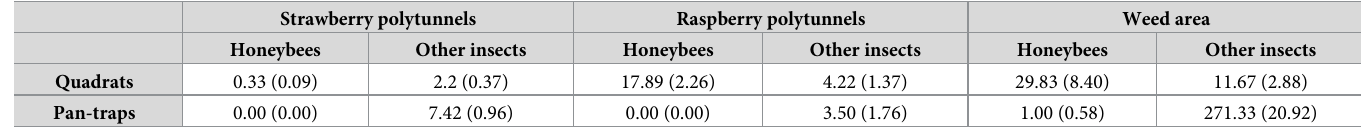
Table 5. Average insect count per location by pan-trap and by quadrat observation using only the middle of polytunnels and weed area with standard error of the mean (SEM) shown in brackets. Strawberry polytunnels Raspberry polytunnels Weed